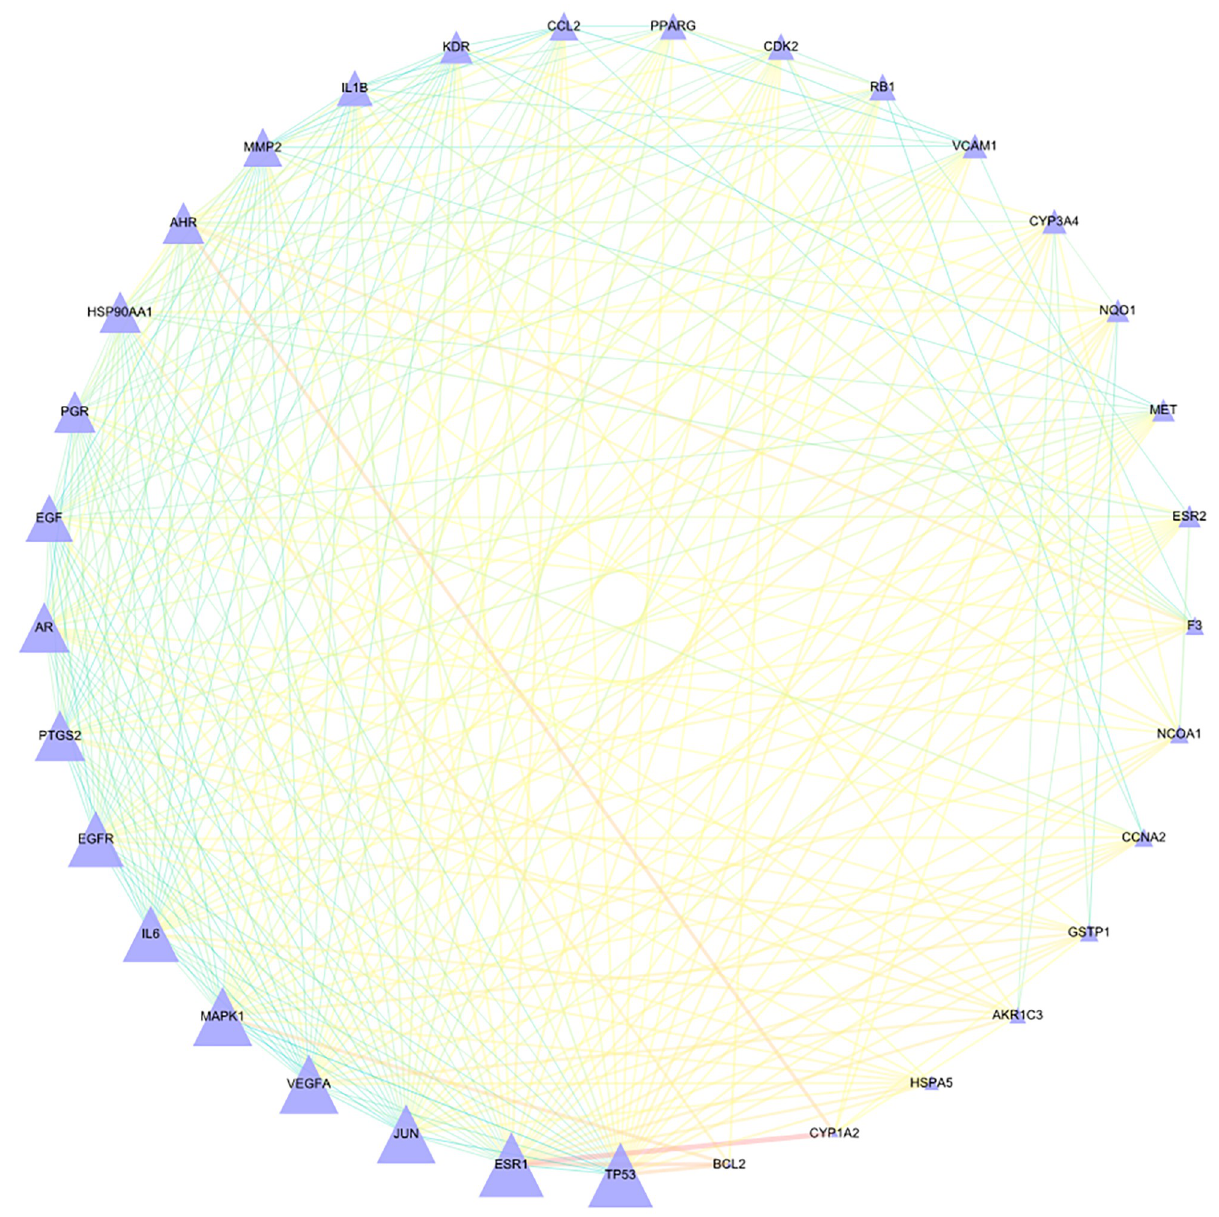
Fig 3. PPI network. 33 overlapped target genes were used to constructed PPI network and hub genes in PPI network. The purple triangle is the target protein. The size of the triangle represents the weight of the target protein.